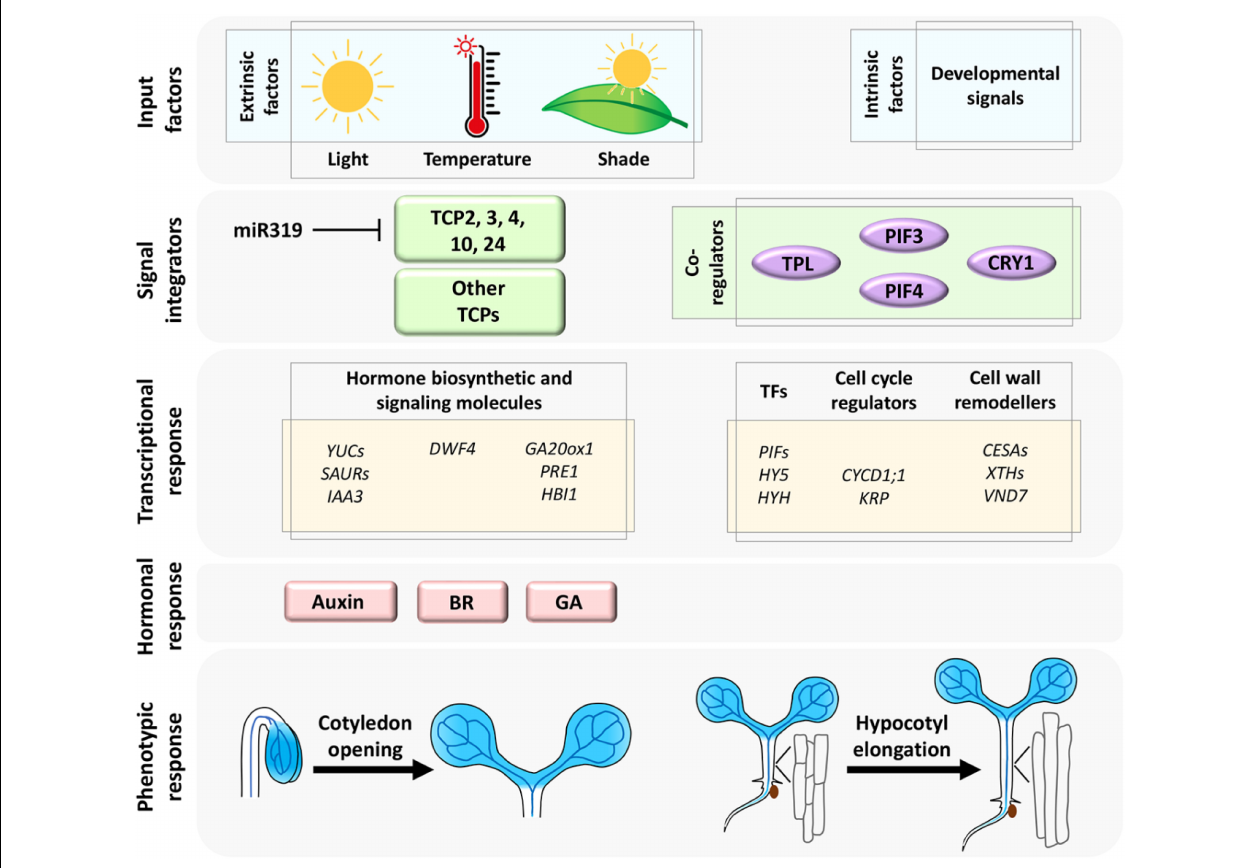
FIGURE 1 | The extrinsic (environmental) and intrinsic (developmental) signals are consolidated by miR319-regulated CIN-TCP transcription factors and their co-regulators (Dong et al., 2019; Ferrero et al., 2019; Zhang et al., 2019; Zhou et al., 2019) to form a regulatory network that activates downstream target molecules and phytohormones to promote cell growth linked to hypocotyl elongation and cotyledon opening. Shaded blue color represents CIN-TCP gene expression pattern.